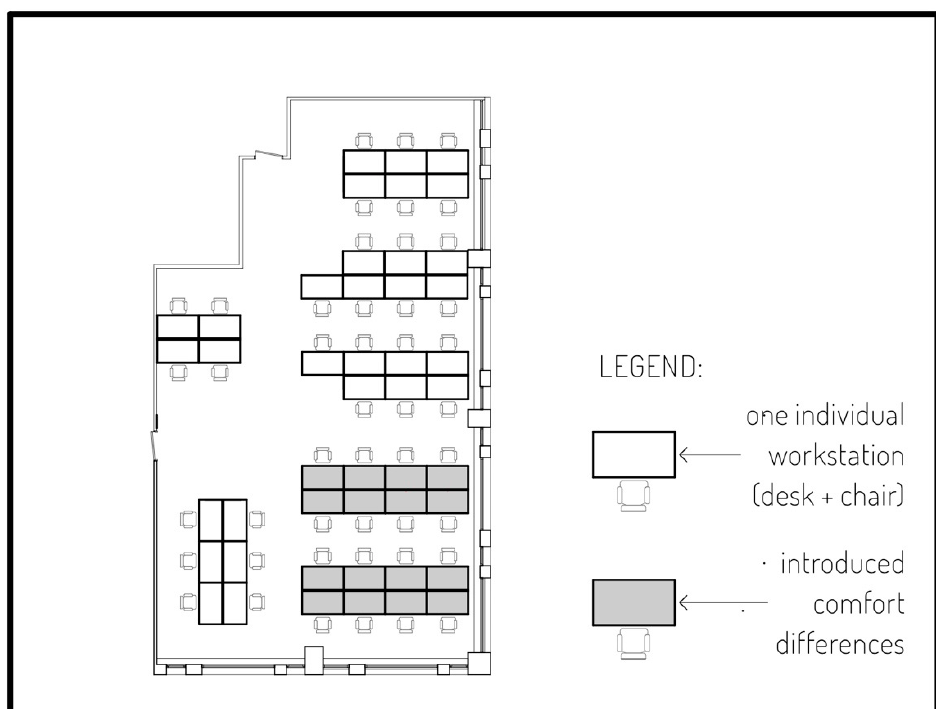
Figure 2. Plan of the office where the measurements were carried out .